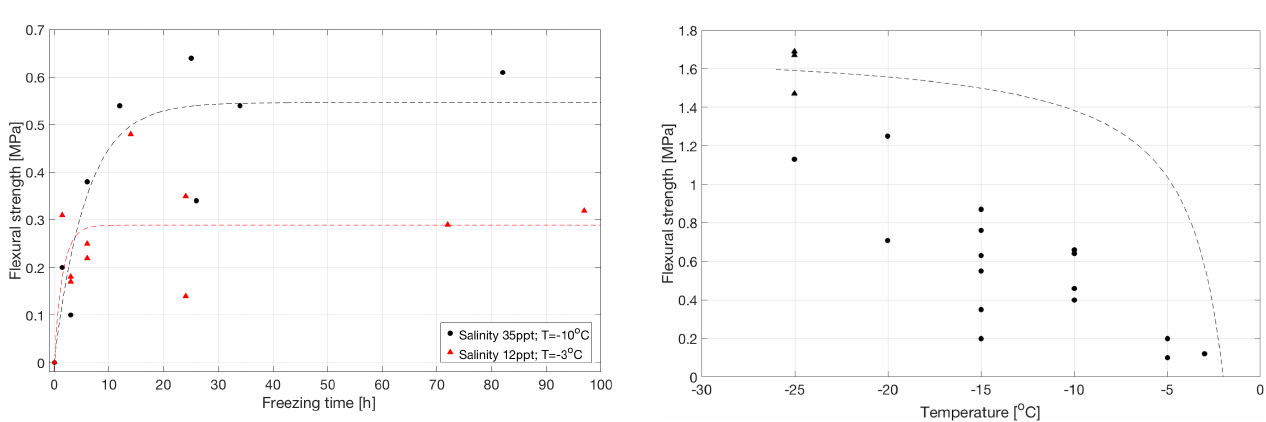
Figure 4. Flexural strength of bonded ice as a function of temper- ature for bonds formed from water of 20ppt salinity. Triangular- shaped points at − 25 ◦ C indicate that actual bond strength is greater than that of the parent material as the failure occurred outside the bond. The dotted line is drawn according to the model in Ap- pendix